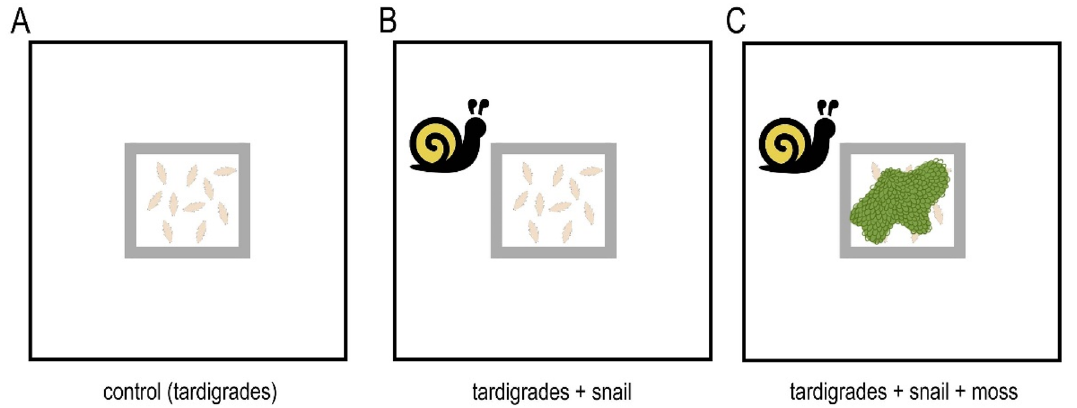
Figure 2. Graphical representation of three designed experimental options of the experiment 1. ( A ) 10 tardigrades in the silicone square (control (C)); ( B ) 10 tardigrades in the silicone square and one snail placed in the box (tardigrades + snail (TS)); ( C ) 10 tardigrades in the silicone square, one snail placed in the box and additional piece of the moss added as a barrier between tardigrades and snail (tardigrades + snail + moss (TSM)). Figures were assembled in Corel Photo-Paint 2017 (http:// www. corel.